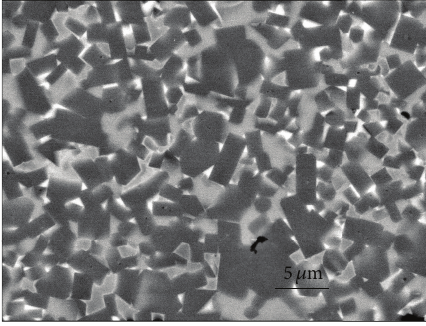
Figure 3: FESEM microstructure of TiC-TiB 2 ceramic